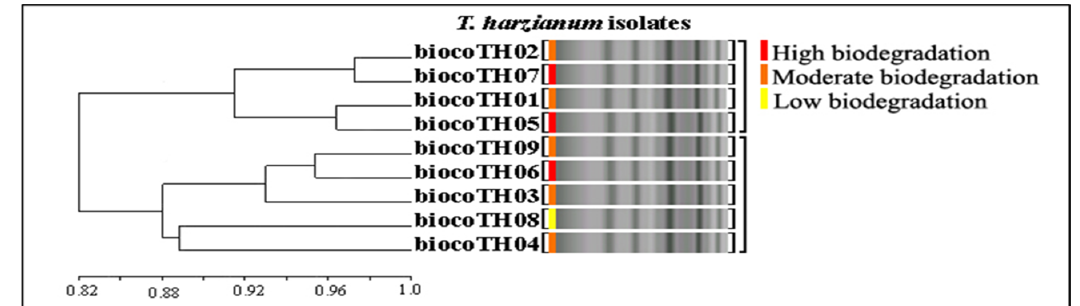
Figure 5. UPGMA dendrogram based on Jaccard’s coefficient illustrating the genetic similarities among nine T. harzianum isolates based on (GA) 8 T primer.